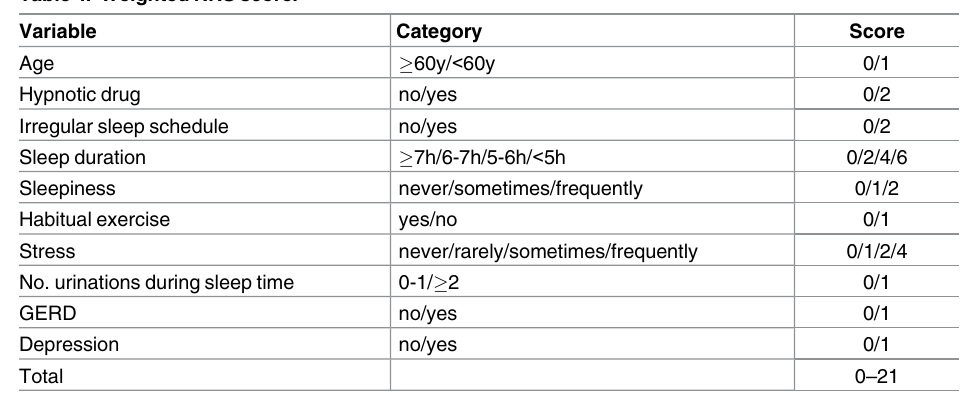
Table 4. Weighted NRS score.